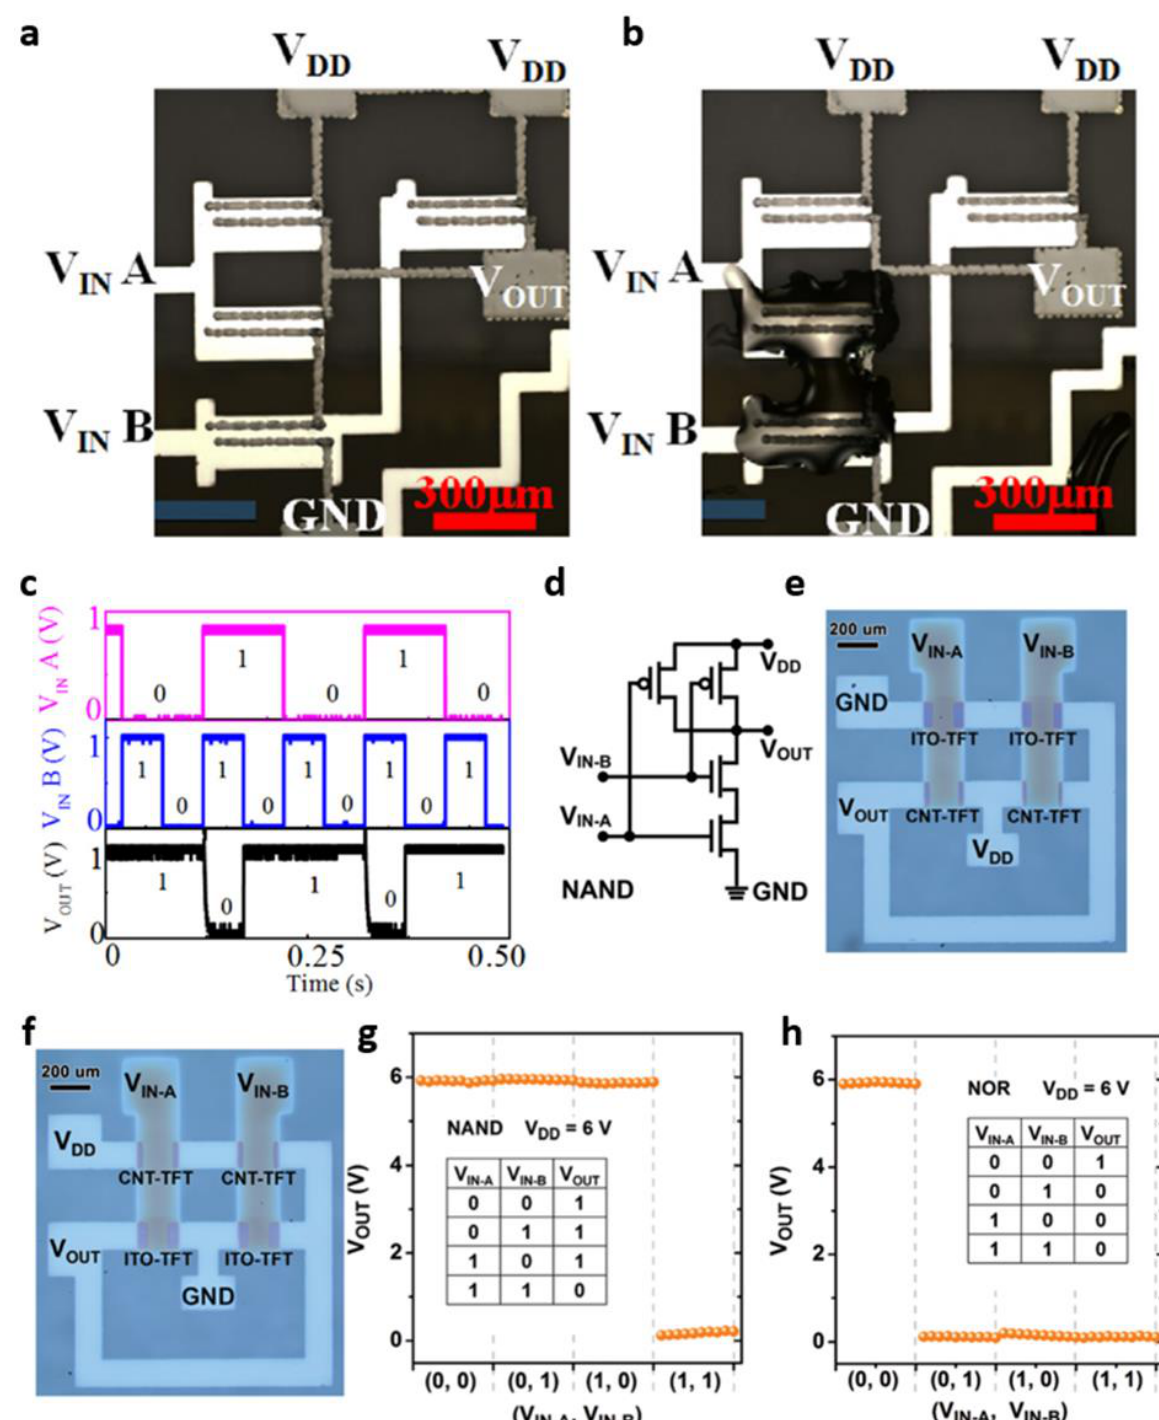
Figure 1. CNT-based digital thin-film circuits. CNT-based NAND circuit ( a ) before and ( b ) after drop-casting of epoxy amine ink and ( c ) output of NAND gate for two final input voltages (A, B). Various SAMs on the SiO 2 surface (adapted from [ 42 ] with permission from Elsevier). ( d ) NAND circuit diagram based on ITO and CNT TFTs. Optical microscopy images of ( e ) NAND and ( f ) NOR circuits based on ITO and CNT TFTs, and ( g , h ) logic input/output characteristics of each circuit (adapted from [ 43 ] with permission from RSC Publishing).